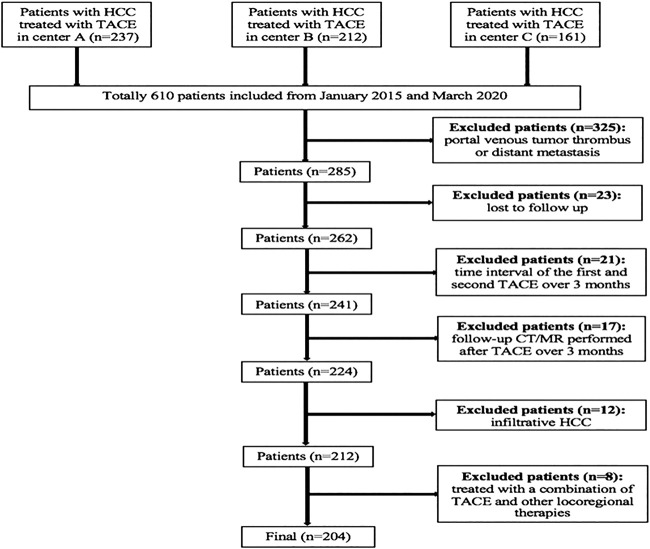
Diagram of the study population.